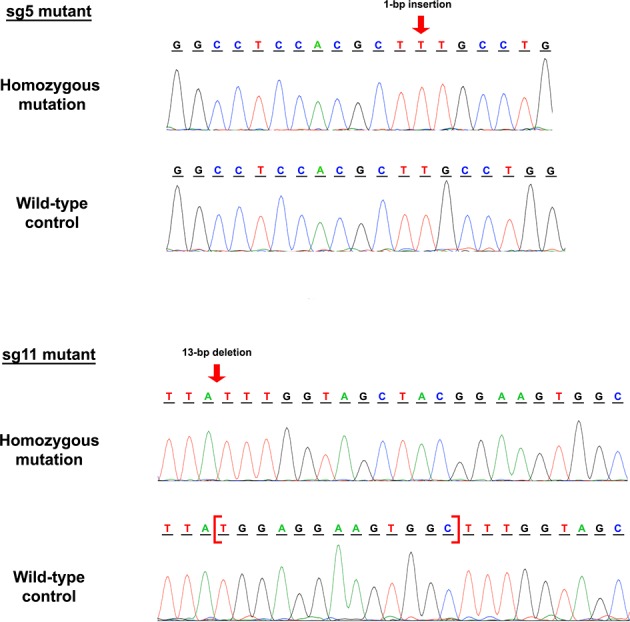
CRISPR mutagenesis targets OCLN at two separate loci on exon 3.Schematics of OCLN sg5 and sg11 mutant DNA sequence and corresponding chromatograms. Both mutants contain homozygous mutations at their respective targeted loci and their wild-type controls are shown as comparison.